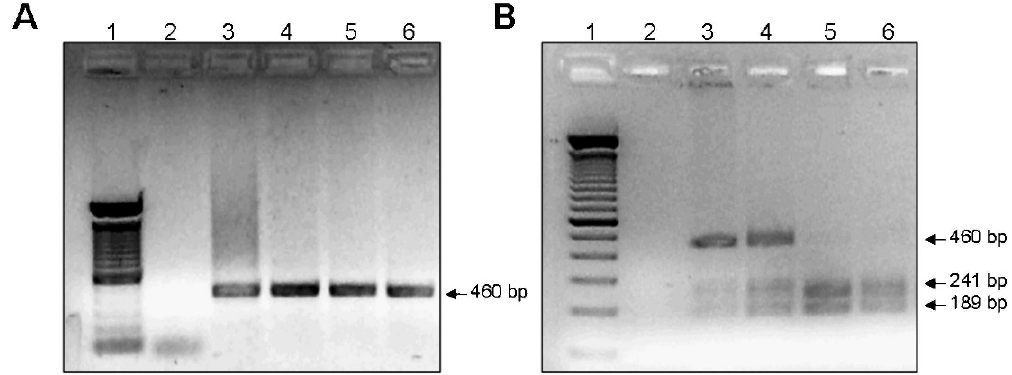
Figure 3 - JAK2 V617F genotyping. (A) PCR amplification of JAK2 : lane 1: 100 bp ladder; lane 2: negative control; lanes 3 to 6 – 460-bp amplicons obtained from the genomic DNA of a patient with PV (3), a CMML patient after disease progression (4) and two MDS patients (with RA) (5 and 6). (B) BsaXI digestion: lane 1: 100 bp ladder, lane 2: negative control; lanes 3 and 4: digestion pattern observed in a PV patient (3) and in the CMML patient positive for the JAK2 V617F allele after disease progression (4); lanes 5 and 6: digestion pattern observed in two MDS patients (with RA) with wild-type JAK2 alleles.